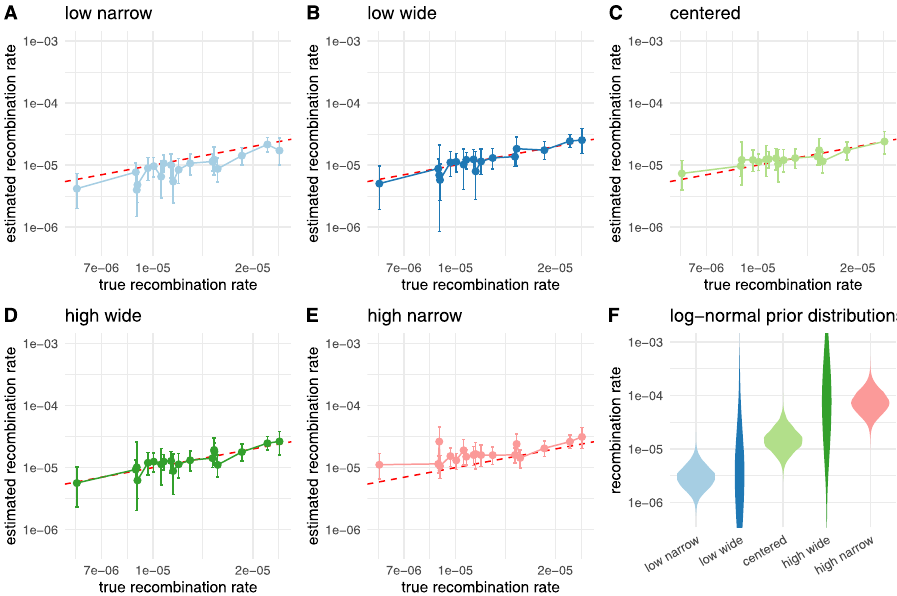
Fig. 5 Impact of the recombination rate prior distribution on the inferred recombination rates. Here, we compare then inferred recombination rates when using different prior distributions that differed from the distributions from which the rates for simulations were sampled. The rates for simulations were sampled from a log-normal distribution with μ = − 11.12 and σ = 0.5. In A , we show the inferred rates when using a prior distribution with μ = − 12.74 and σ = 0.5 (leading to a 5 times lower mean in real space than the correct prior). In B , we show the inferred rates when using a prior distribution with μ = − 12.74 and σ = 2. In C , we show the inferred rates when using the same prior distribution as was sampled under. In D , we show the inferred rates when using a prior distribution with μ = − 9.72 and σ = 2. In E , we show the inferred rates when using a prior distribution with μ = − 9.72 and σ = 0.5 (leading to 5 times higher mean in real space than the correct prior). F shows the corresponding density plots for all log-normal distributions used as prior distributions on the recombination